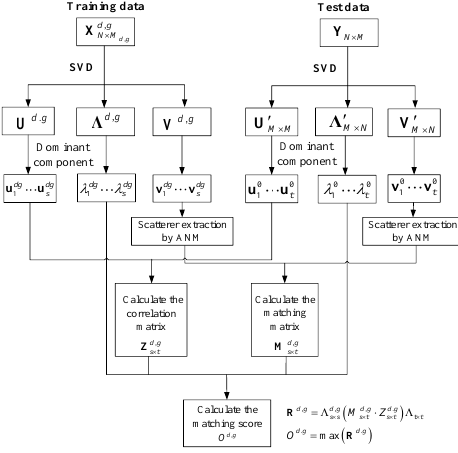
Figure 3. Implementation flowchart of the SSM-ANM method.